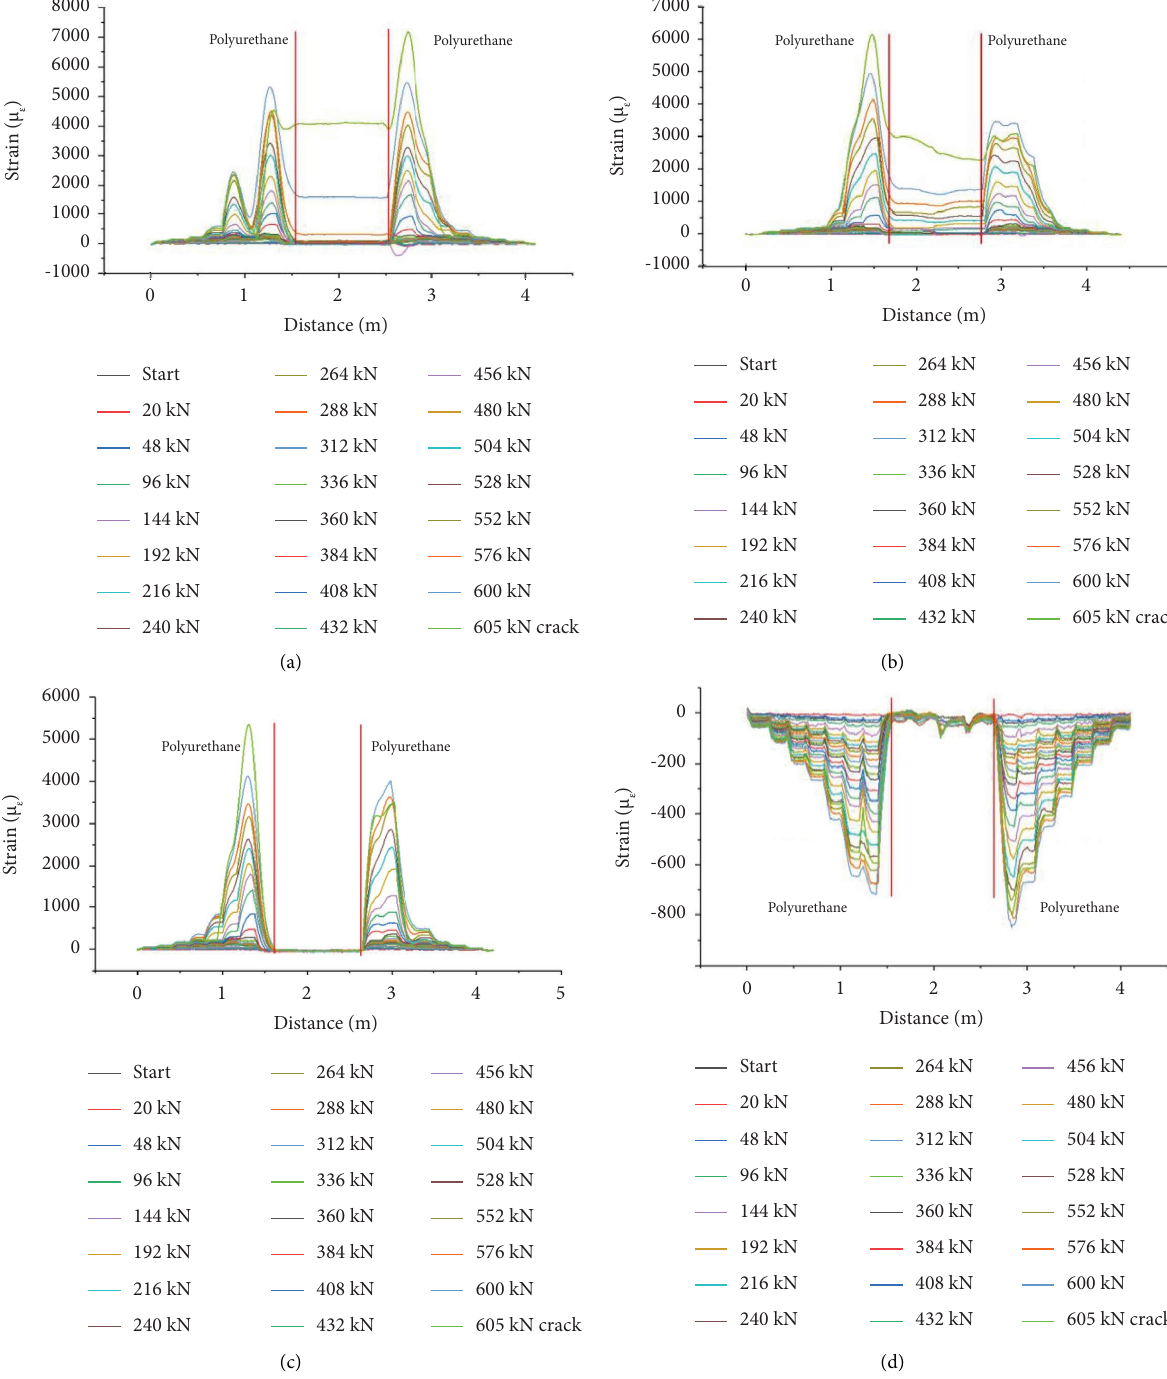
Figure 9: Strain diagram of polyurethane optical cable on the top, back, and front of 5-1. (a) Top. (b) Back. (c) Upper of front. (d) Lower of